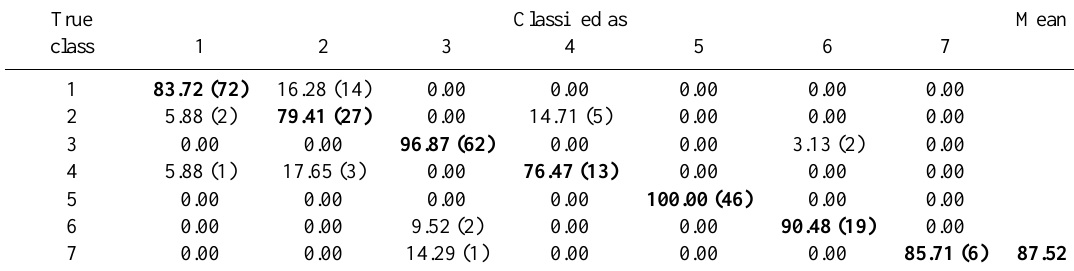
Table 6. Confusion matrix of the random sample TEST (275 images) for serious errors in % and absolute. True Classified as Mean